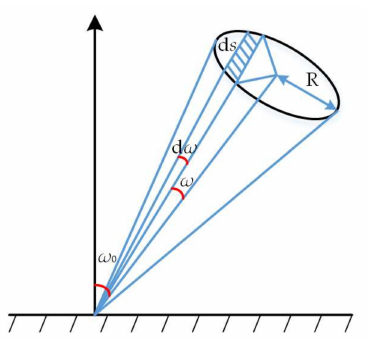
Figure 6. Schematic of a beam for received